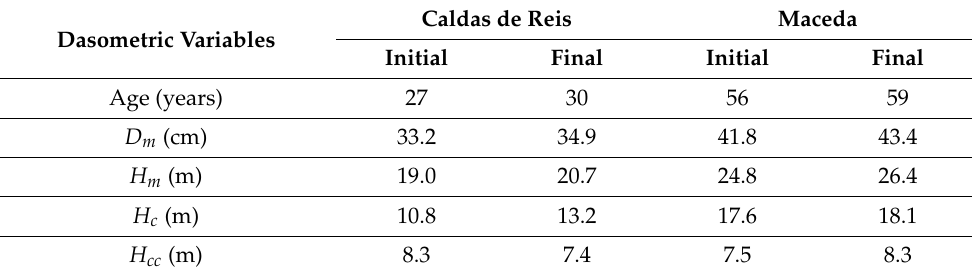
Table 1. Dasometric characteristics of the two study plots: Caldas de Reis and Maceda. D m is the mean normal diameter (measured at a height of 1.3 m above ground level), H m is the mean total tree height, H c is the mean height to the start of crown, H cc is the calculated mean crown height. Measurements were taken the first year of the experience before tapping (initial) and in the autumn-winter just after the last tapping season (final).